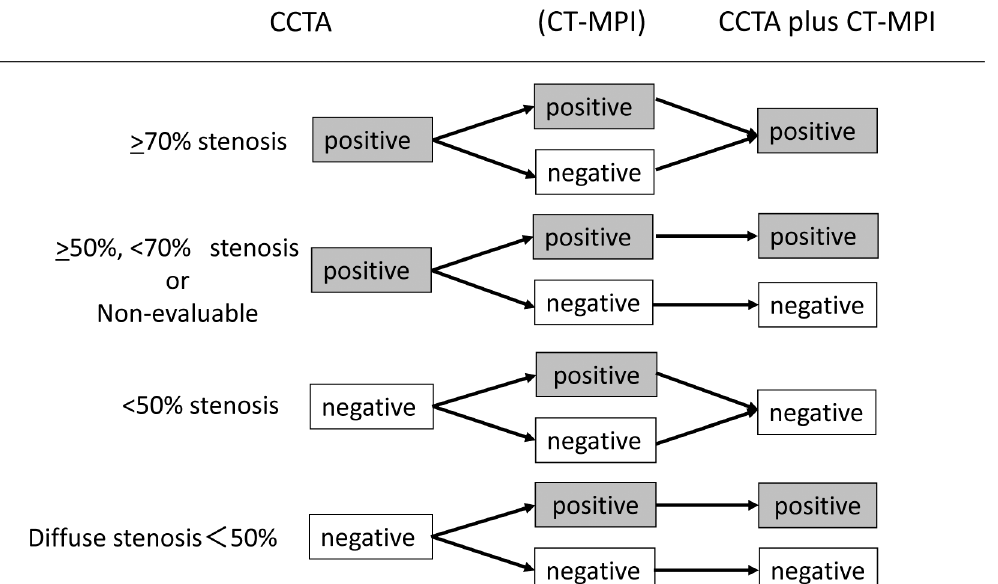
Fig 1. Reclassification criteria. Before CT-MPI analysis, nonevaluable with CCTA was defined as positive for stenosis using the following criteria: those with no vessel wall definition owing to marked motion artifacts or heavy calcification that precluded acquisition of diagnostic information. doi:10.1371/journal.pone.0149170.g001 PLOS ONE | DOI:10.1371/journal.pone.0149170 February 19,